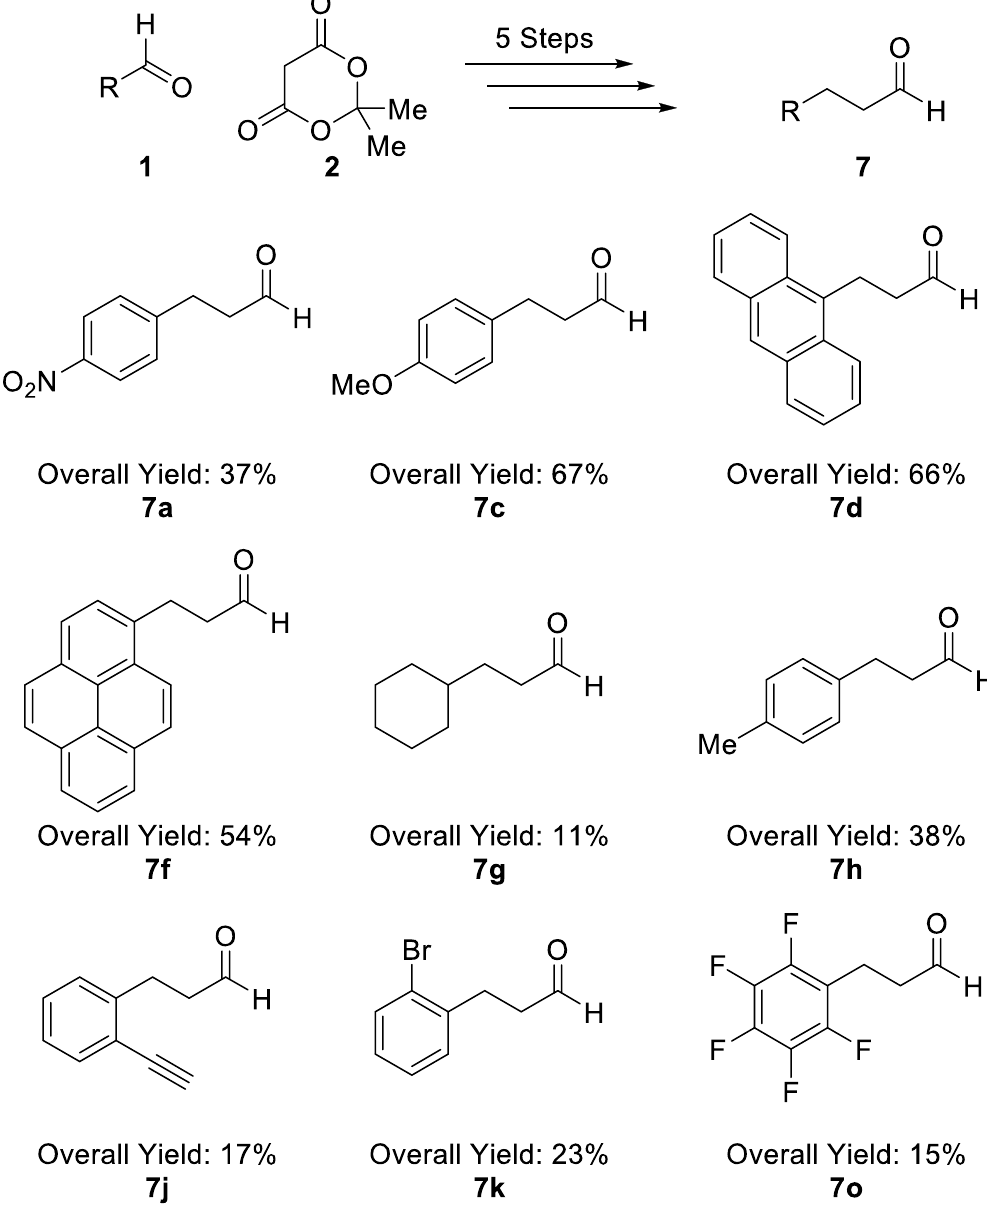
Figure 9. Summary of five step synthesis of hydrocinnamaldehyde derivatives with overall